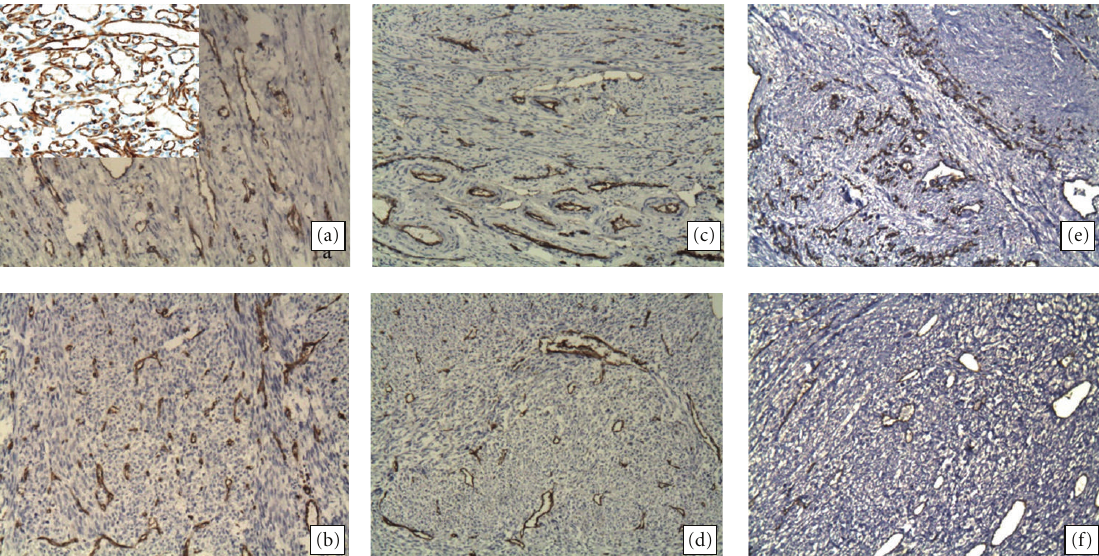
Figure 4: MVD (as evaluated by CD31 expression) in LMS vessels ((b), (d), (f)) and peritumoral area ((a), (c), (e)). Immunohistochemistry technique, magnification × 200. There were no significant di ff erences in the MVD between LMS and the PA. MVD in LMS at grade 1 phase (b) was higher than at grade 2 and grade 3 phases; however, in each tumor case, indices varied in the same manner as the MVD in the PA. A positive control for CD31 (capillary hemangioma, × 400) is shown in the left upper